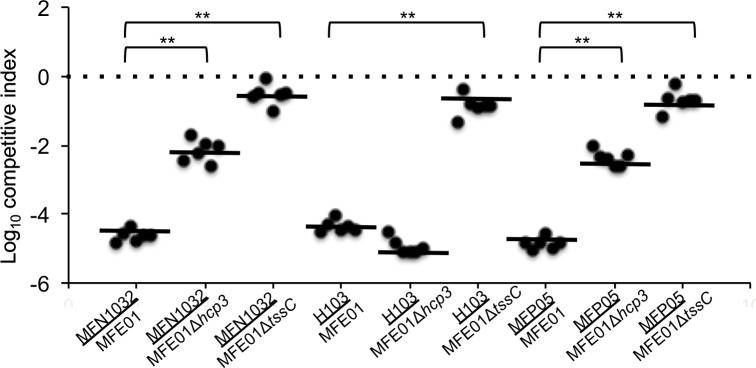
Competitive index of MFE01, MFE01ΔtssC and MFE01Δhcp3.MFE01, MFE01ΔtssC or MFE01Δhcp3 (attackers) were mixed with MFP05, MFN1032 or H103 (preys). The mixture was incubated on nutrient agar for 4 h, and survival were enumerated by plating survivors on appropriate selective plates. The competitive index is calculated using the equation: (input attacker/input prey)/(output attacker/output prey). Horizontal bars indicate the arithmetic mean of log-transformed data. ** indicates statistical significance (Wilcoxon signed rank test, p-value < 0.05), n = 6.